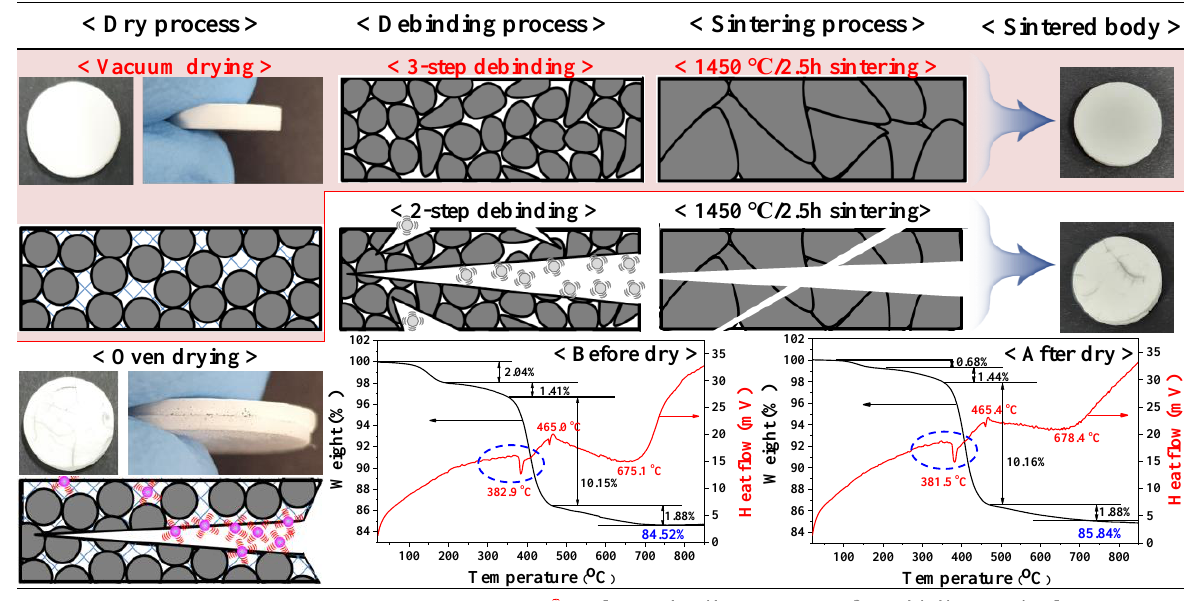
Figure 2. Schematic diagram for optimization of drying and debinding conditions for 3YSZ 3D-printed objects to minimize internal stress generated from removing materials such as solvents, residues, and polymers based on TG-DTA analysis.